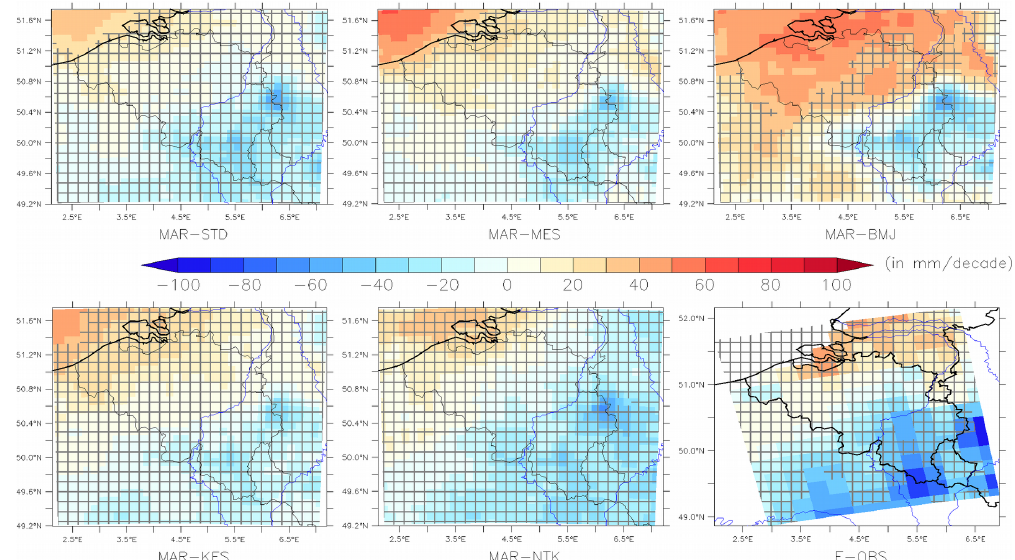
Figure 5. Trends in annual precipitation simulated by MAR for each experiment and provided by E-OBS over 1987–2017 in mm/decade. Crosshatched pixels indicate statistically non-significant trends.